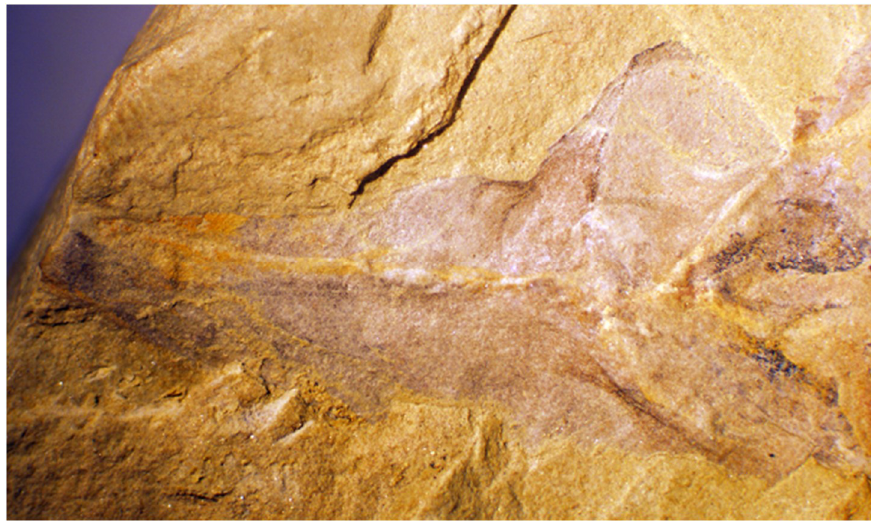
Figure 20. Shenzianyuloma yunnanense nov. gen. nov. sp. IGM 5008. Detail of tail region showing notochord and posterior gut trace. Photo Credit: Mark McMenamin.